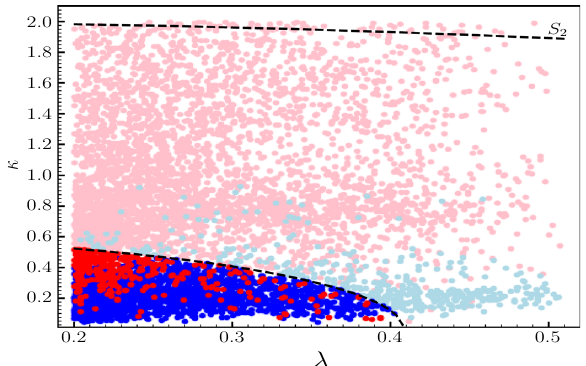
Fig. 8 Viable points of the parameter space for S 2 in the κ − λ plane. Theredandlight-red(blueandlight-blue)coloursrepresentcaseswhere the SM-like Higgs is (is not) the lightest scalar. All red and blue points below the lower black dashed line fulfill the perturbativity condition up to GUT scale of Eq. (25). Light-red and light-blue points below the upper black dashed line fulfill the perturbativity condition up to 10 TeV of Eq. (26)